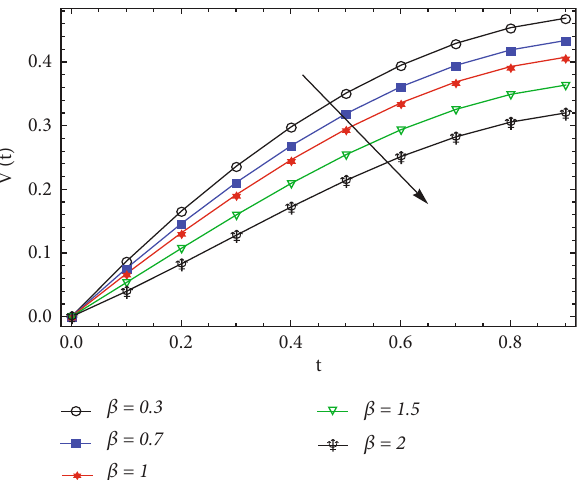
Figure 5: In drainage case e ff ect of α on V ð x Þ where g = 1 are fi xed.